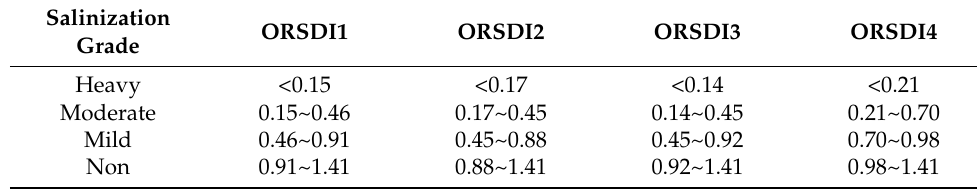
Table 5. Thresholds of different levels of soil salinity.